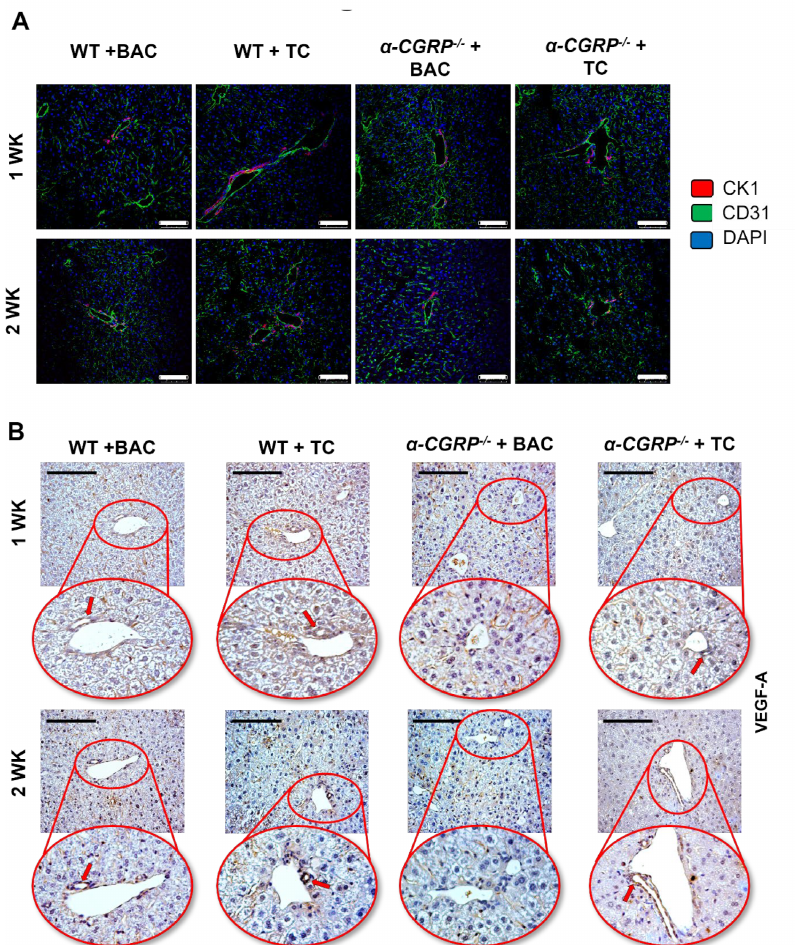
Figure 10. Knockout of α -CGRP decreased angiogenic factor expression in mice fed with TC diet. ( A ) TC treated WT mice showed enhanced immunoreactivity of CD31 (angiogenic marker) compared to WT mice treated with BAC diet; this parameter is decreased in TC-fed α -CGRP − / − mice. Orig- inal Magnification 20 × ; scale bar 100 µ m. ( B ) Immunohistochemistry for VEGF-A in liver section demonstrated reduction of the angiogenic factor both in BAC- and TC-fed α -CGRP − / − mice. Original magnification 20 × ; scale bar 100 µ m. Data are mean ± SEM of scanning slides from n = 3 animals per each experimental